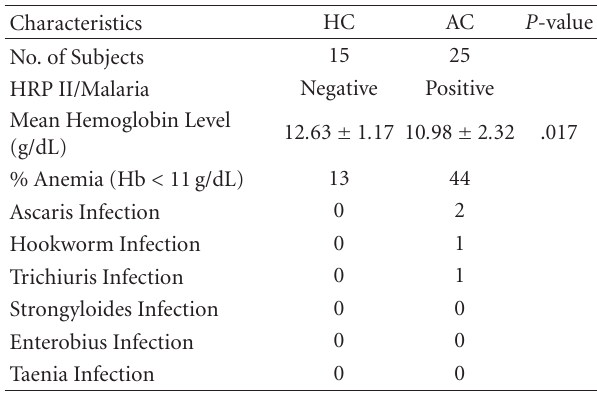
Table 1: Description of the pregnant women in the study. HC denotes healthy control and AC denotes asymptomatic carrier. The values for hemoglobin was mean ± SD .